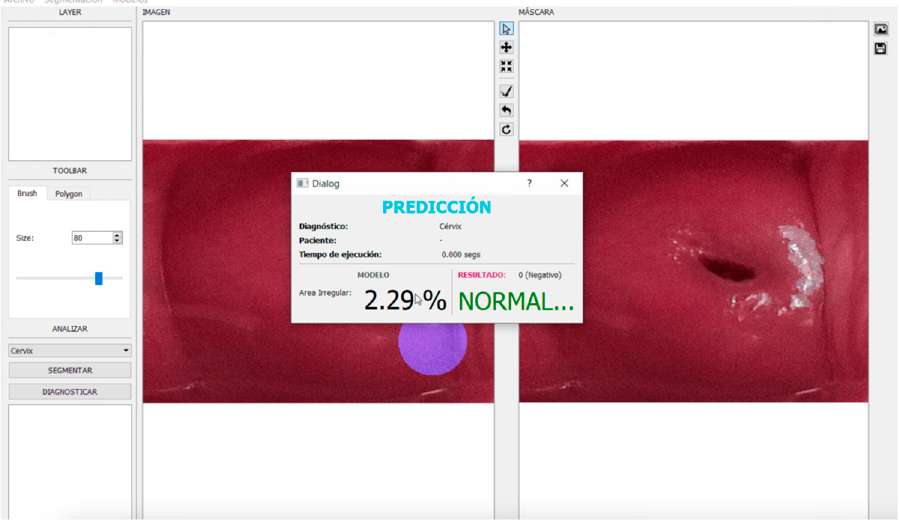
Figure 7. Graphical Interface for colposcopy image classification.